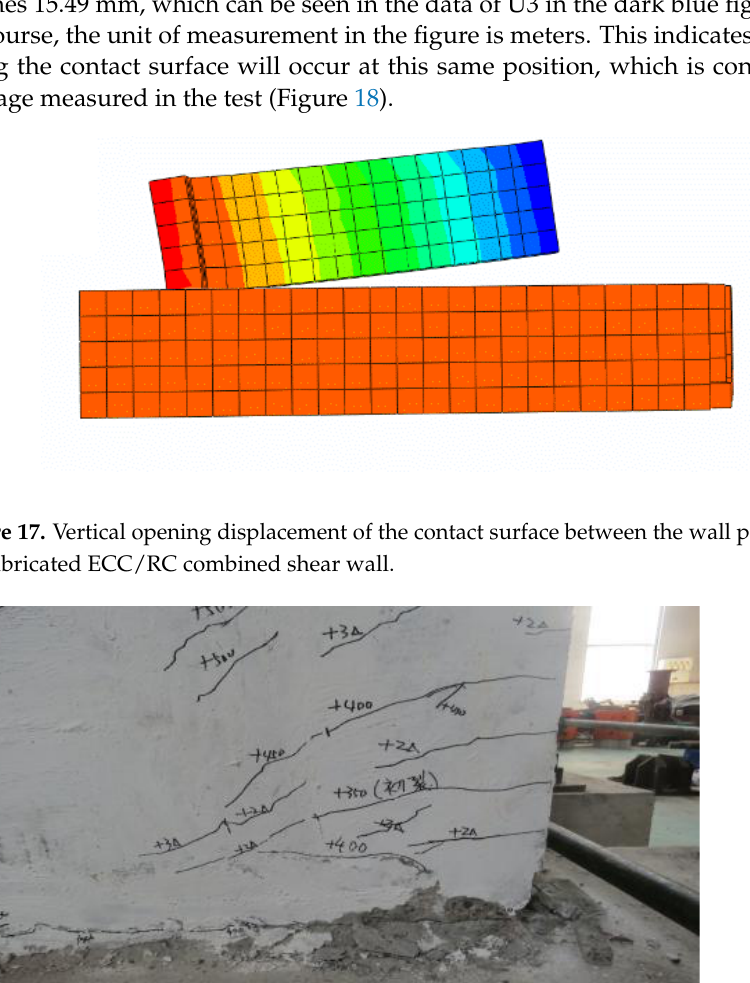
Figure 18. The damage of the contact surface between the wall pier and the base measured in the test.